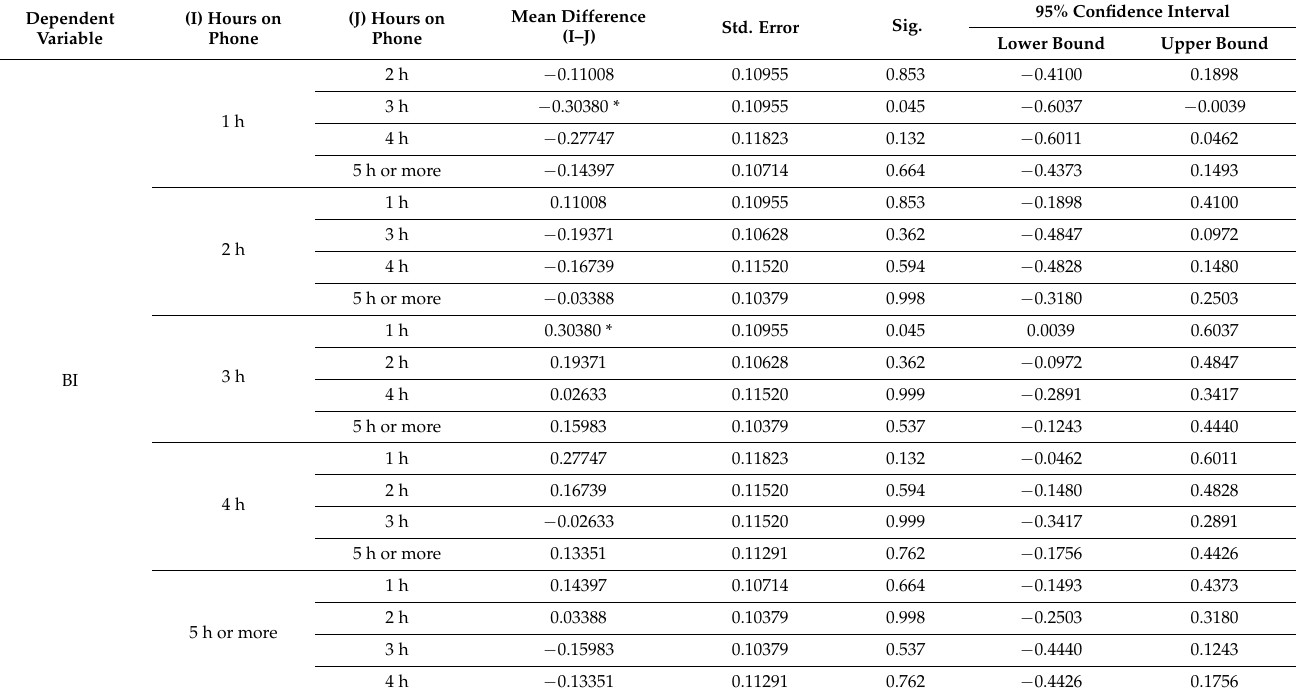
Table 18. Multiple comparisons analysis of the BI attributed to the number of hours on a smartphone using Tukey HSD.